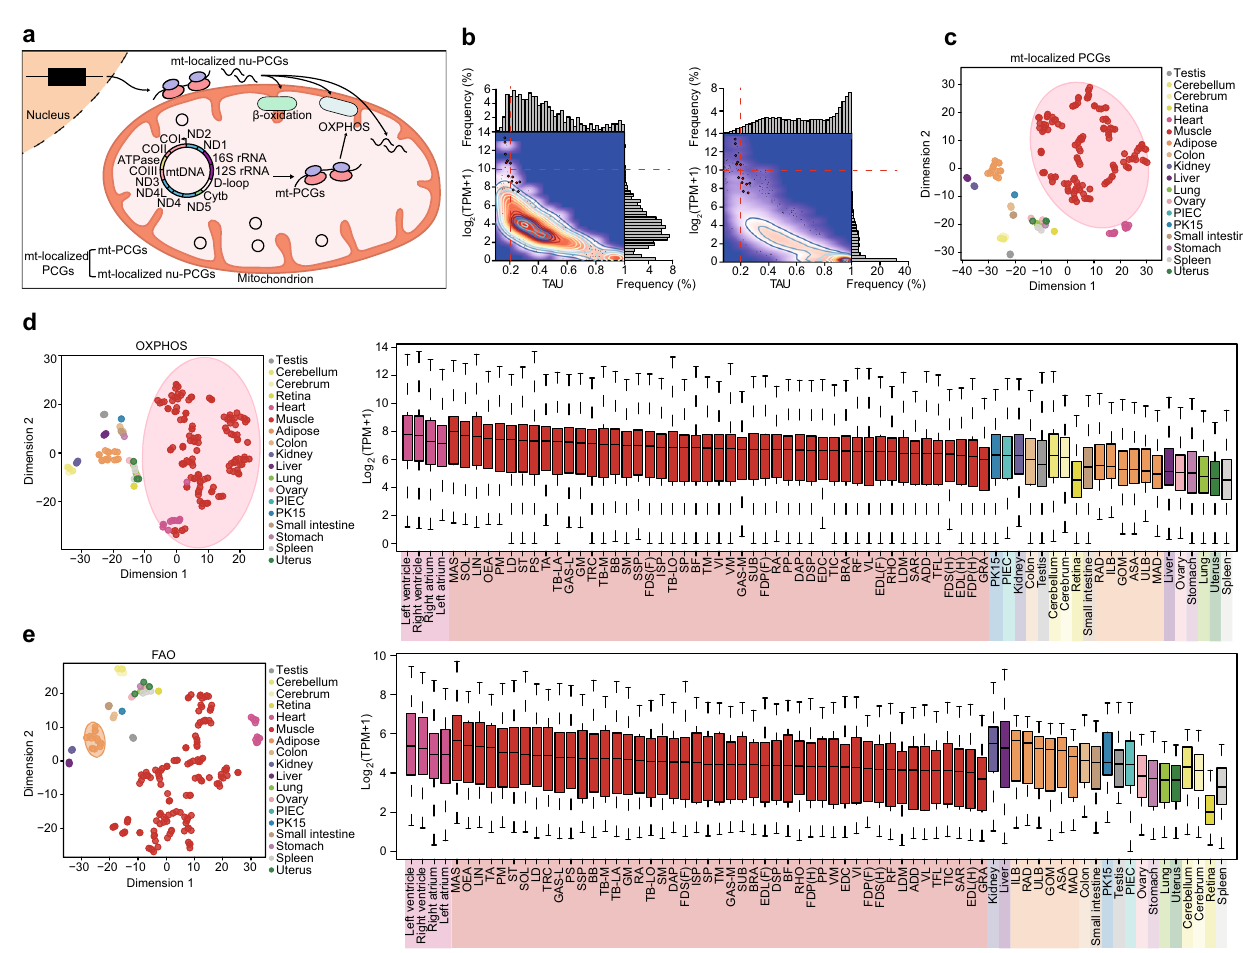
Fig. 5 Transcriptional patterns of diverse mitochondrial pathways across tissues. a Schematic representation of mitochondrial structure depicting the compendium of mitochondrial PCGs, including 13 PCGs encoded by mitochondrial DNA and 1043 post-translationally imported nuclear PCGs. mt-PCGs: mitochondrial protein coding genes; mt-localized nu-PCGs: mitochondria-localized nuclear PCGs. b Density/contour plots of the distribution of tissue speci fi city ( τ ) and transcription level (TPM: transcripts per million) for PCGs located within (left panel) or outside of (right panel) the mitochondria. Data points in the plot indicate the 13 mt-PCGs, with the horizontal and vertical dashed lines indicating the average transcription level and tissue speci fi city of these mt-PCGs, respectively. c t-SNE plot depicting the transcriptional patterns of all mt-localized PCGs across 72 tissues. The transcription levels were log 2 -transformed. d t-SNE plot showing clustering of the transcriptional patterns of mt-localized OXPHOS PCGs across tissues (left panel). Ellipse in the t-SNE plot indicates clustering of SMTs, constructed at a probability of 0.95. The boxplot indicates dynamic transcription levels (right panel, n = 88). In the boxplot, the internal line indicates the median, the box limits indicate the upper and lower quartiles and the whiskers extend to 1.5 IQR from the quartiles. e t-SNE plot showing clustering of the transcriptional patterns of the mt-localized FAO PCGs across tissues (left panel). Ellipse in the t-SNE plot indicates the AT cluster, constructed at a probability of 0.95. The boxplot indicates the dynamic transcription levels (right panel, n = 36). In the boxplot, the internal line indicates the median, the box limits indicate the upper and lower quartiles and the whiskers extend to 1.5 IQR from the quartiles. Source data for b – e are provided as a Source Data fi